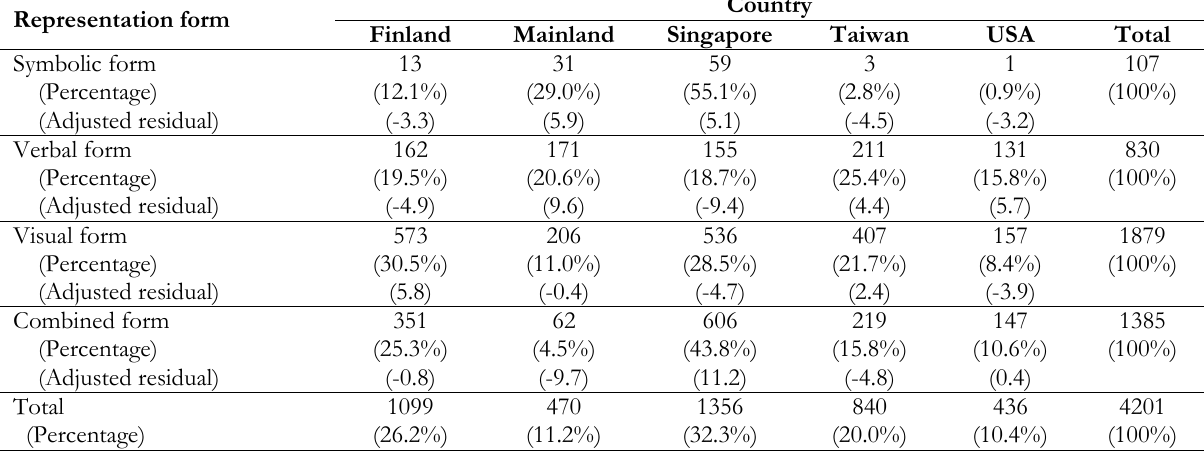
Table 1. Cross-tabulation of representation form and country with adjusted residuals